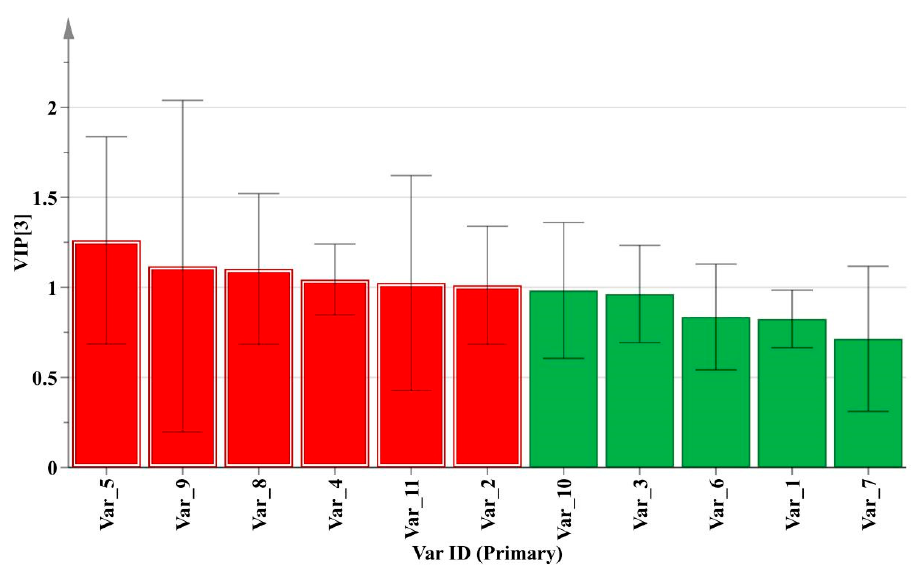
Figure 5. VIP plot for training set samples based on PLS-DA method.